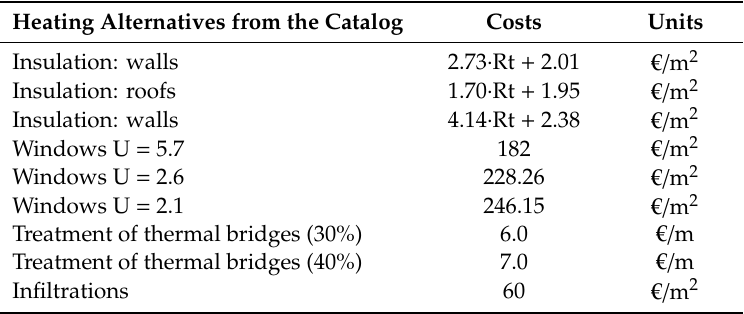
Table 5. Extra costs associated with the improvements